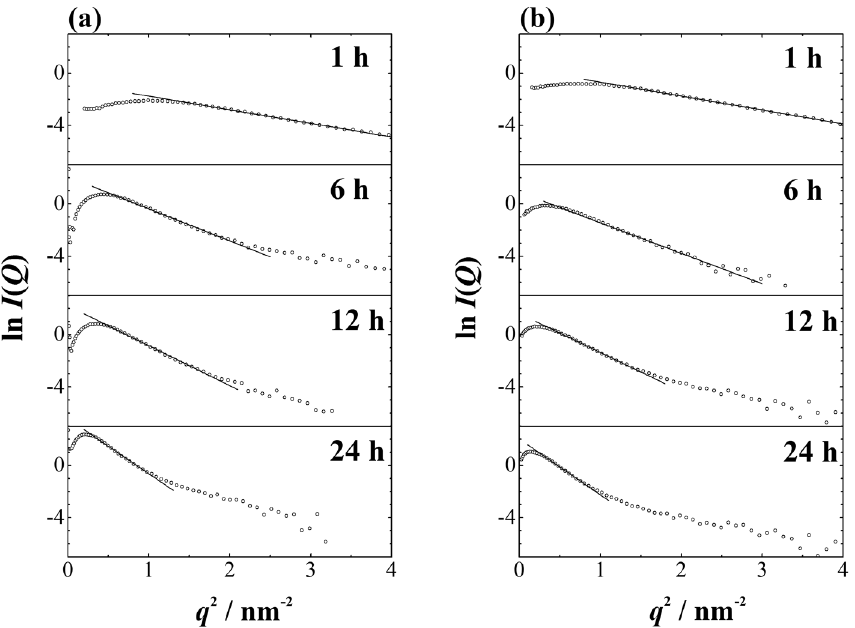
Fig. 7: Guinier plots of SAXS profiles of (a) ST and (b) ST + CR specimens. The solid line indicates a fitted line using Eq. (1).